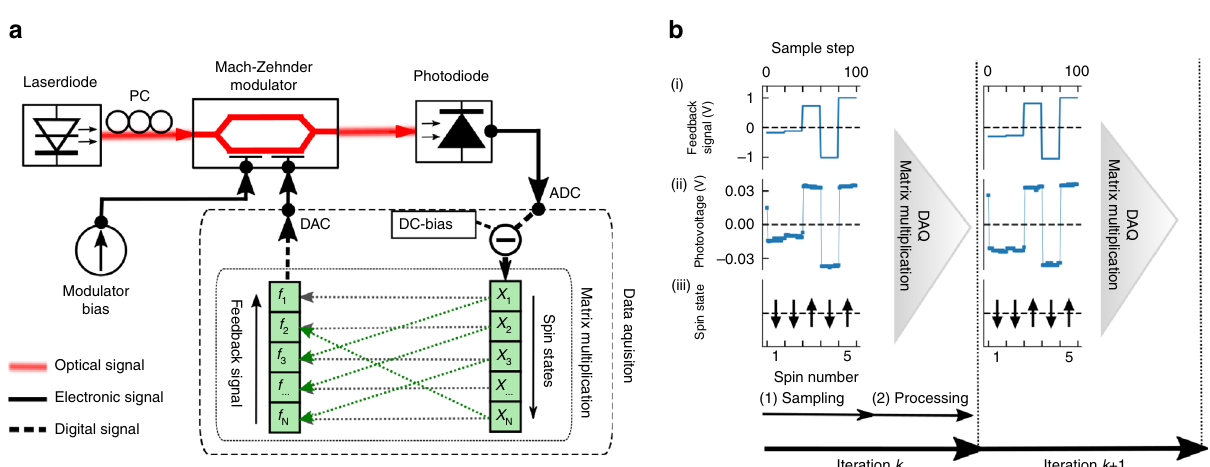
Fig. 1 Experimental schematic and working principle. a Experimental schematic of an OEO-based coherent Ising machine. PC polarization controller, ADC analog – digital converter, DAC digital – analog converter. b Working principle during two consecutive iterations. In the sampling stage (1), the feedback signal is generated (i) and the resulting spin amplitude is measured (ii). The spins states are then determined by the sign of the spin amplitude (iii). In the processing stage (2), spins are digitally processed and the matrix multiplication of Eq. (3) is